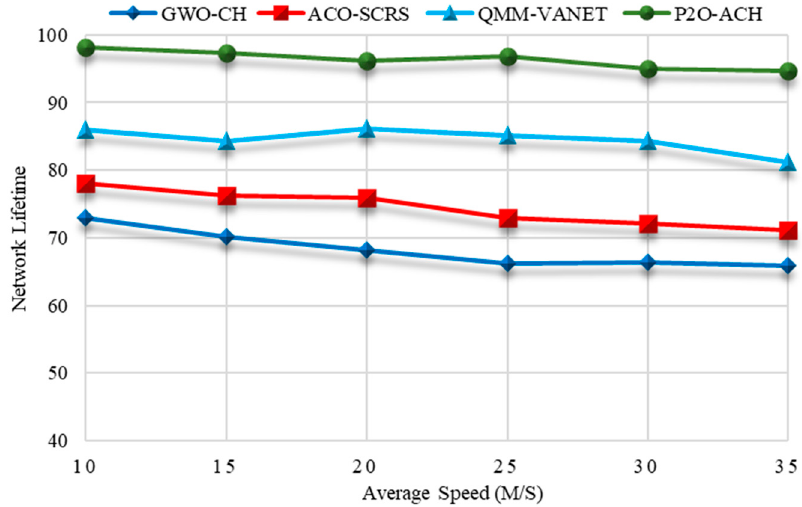
Figure 13. Network Lifetime Calculation.